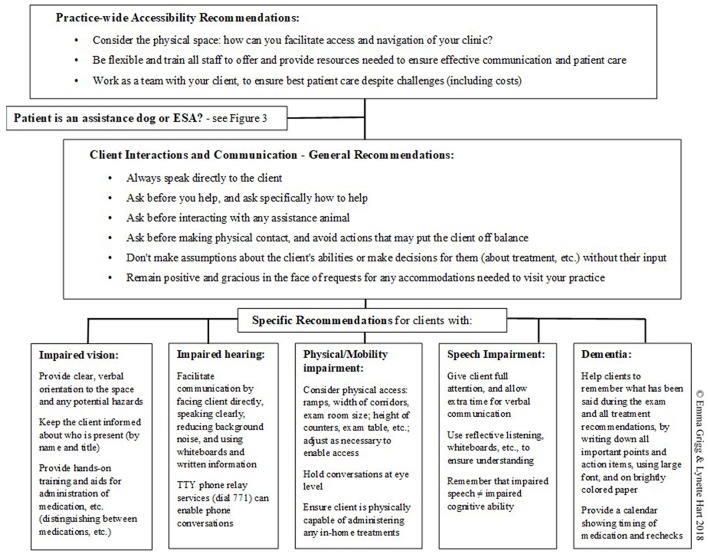
Summary of recommendations for working with clients with disabilities. Detailed recommendations and references are provided in the text (©Emma Grigg & Lynette Hart 2018).